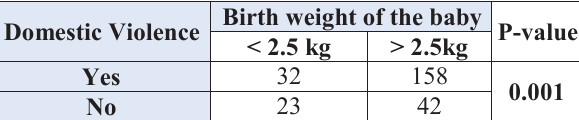
Table-4: Association of antenatal domestic violence